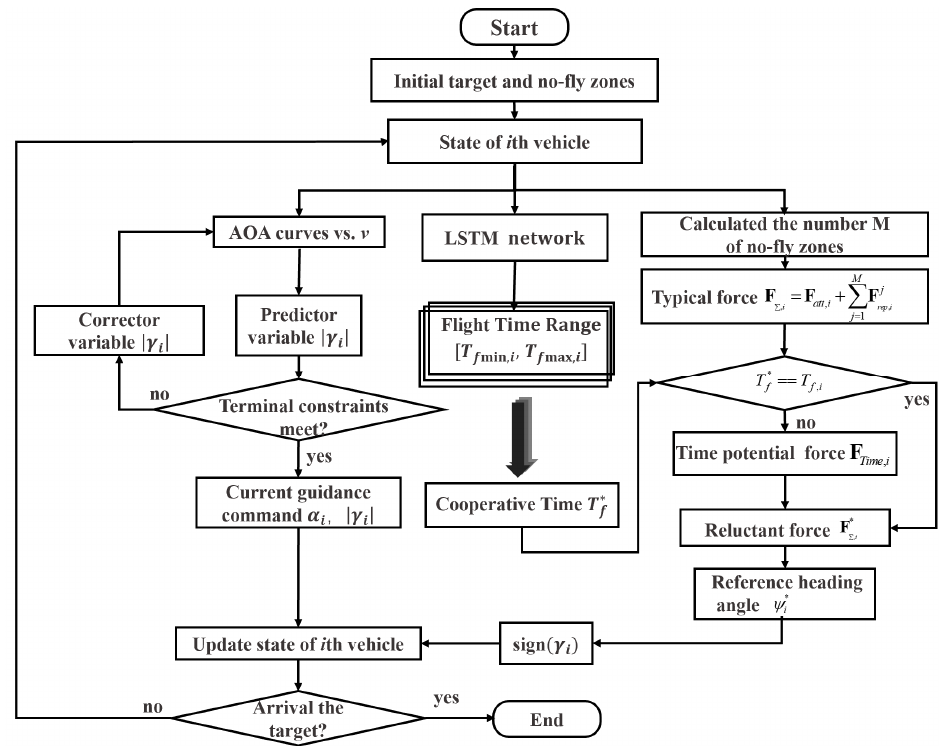
Figure 5. The flow chart of time cooperation guidance.